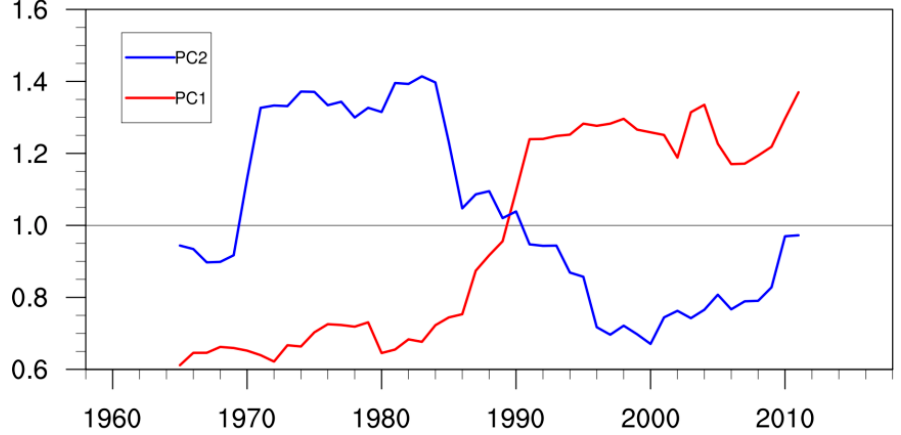
Figure 9. The 15-year running standard deviation of PC1 (red line) and PC2 (blue line) for the period of 1958 to 2018. The years on abscissa are the central year of the 15-year window.